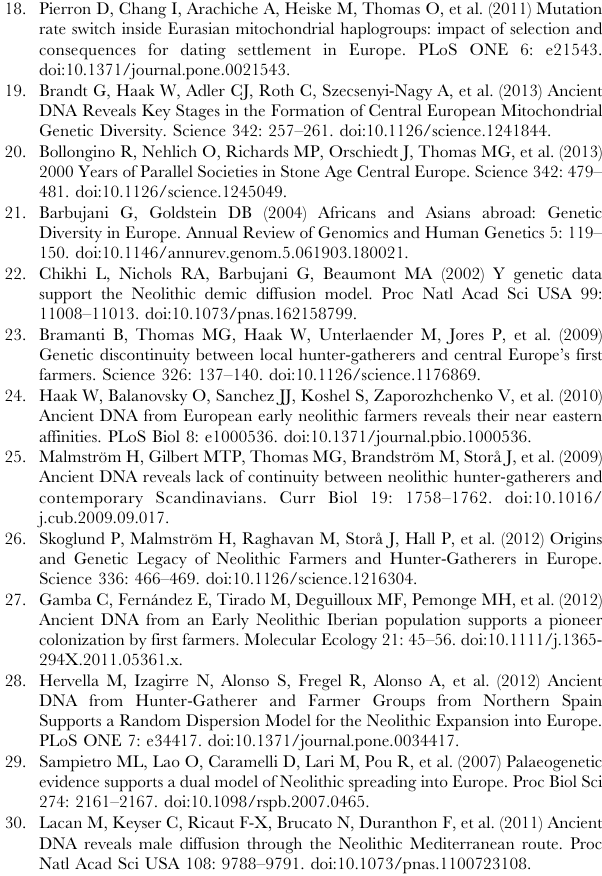
Table S7 MtDNA haplogroup frequencies of PPNB and populations of the database. Sheet 1: Absolute frequencies, Sheet 2: Relative frequencies, Sheet 3: 95% confident interval (CI) for haplogroup frequencies found in the PPNB sample, Sheet 4: Plots of haplogroup frequencies in modern and ancient populations from the database. Only haplogroups present in the PPNB, Cardial/Epicardial and LBK populations are displayed. Population labels are described in Table S4. (XLSX) Table S8 Details of the PCA-HCA performed over haplogroup frequencies of the PPNB sample and the other populations of the database. Population labels are described in Table S4. (XLSX) Table S9 Pairwise F ST values between the PPNB sample and the populations included in the haplotype database. Sheet 1: F ST values, Sheet 2: P values corrected by the Benjamini- Hochberg method [80]. (XLSX) Table S10 Archaeological and anthropological informa- tion of the studied samples. Tooth samples are labeled according to FDI World Dental Federation nomenclature when the type of tooth is known. Other cases are labeled as follows: I: Incisor, C: Canine, P: Premolar, M: Molar. Definitive teeth are labeled in upper-case letters and deciduous teeth in lower-case letters. Dental germs are indicated by ‘‘g’’ before the tooth nomenclature. (DOCX)